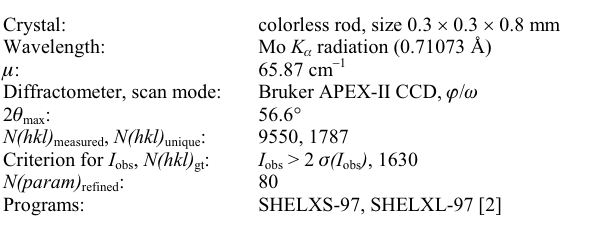
Table 1. Data collection and handling.